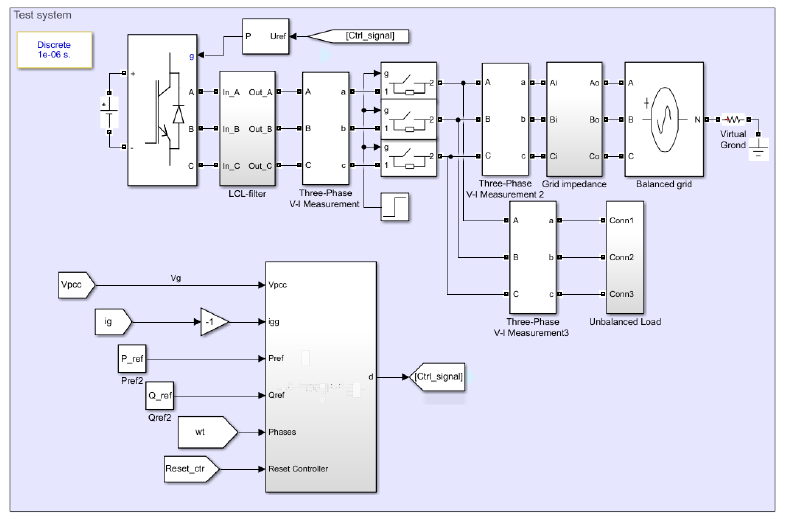
Figure 7. Simulink